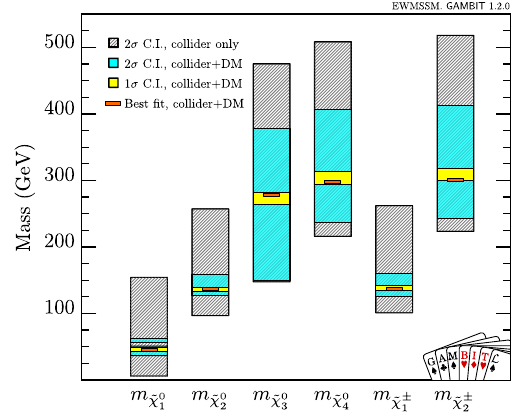
Fig. 18 Summary of the one-dimensional 1 σ (yellow) and 2 σ (cyan) confidence intervals for the neutralino and chargino masses, resulting from the joint collider and dark matter likelihood. For comparison, the 2 σ confidence intervals from the collider likelihood alone are shown in grey (hatched). The orange lines mark the best-fit